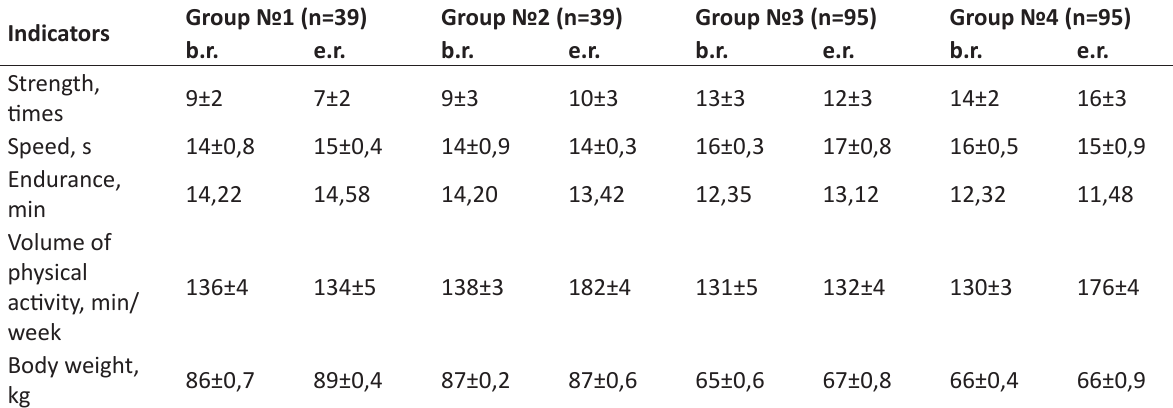
Table 1. Indicators of physical development and physical fitness of students (males – n=78; females – n=190).